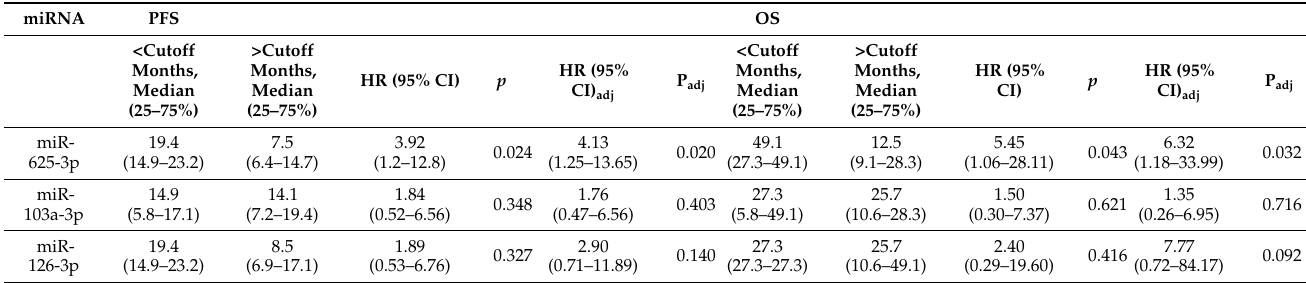
Table 4. Relative change in expression of serum EV-enriched miRNAs and progression-free survival (PFS) and overall survival (OS) of malignant mesothelioma patients.